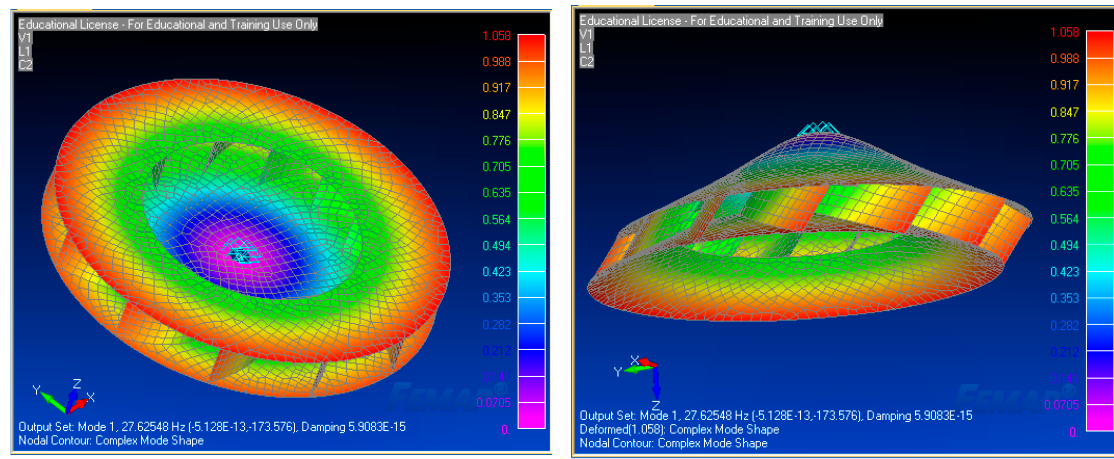
Figure 12. Dynamic simulation first mode, 27.62548 Hz.